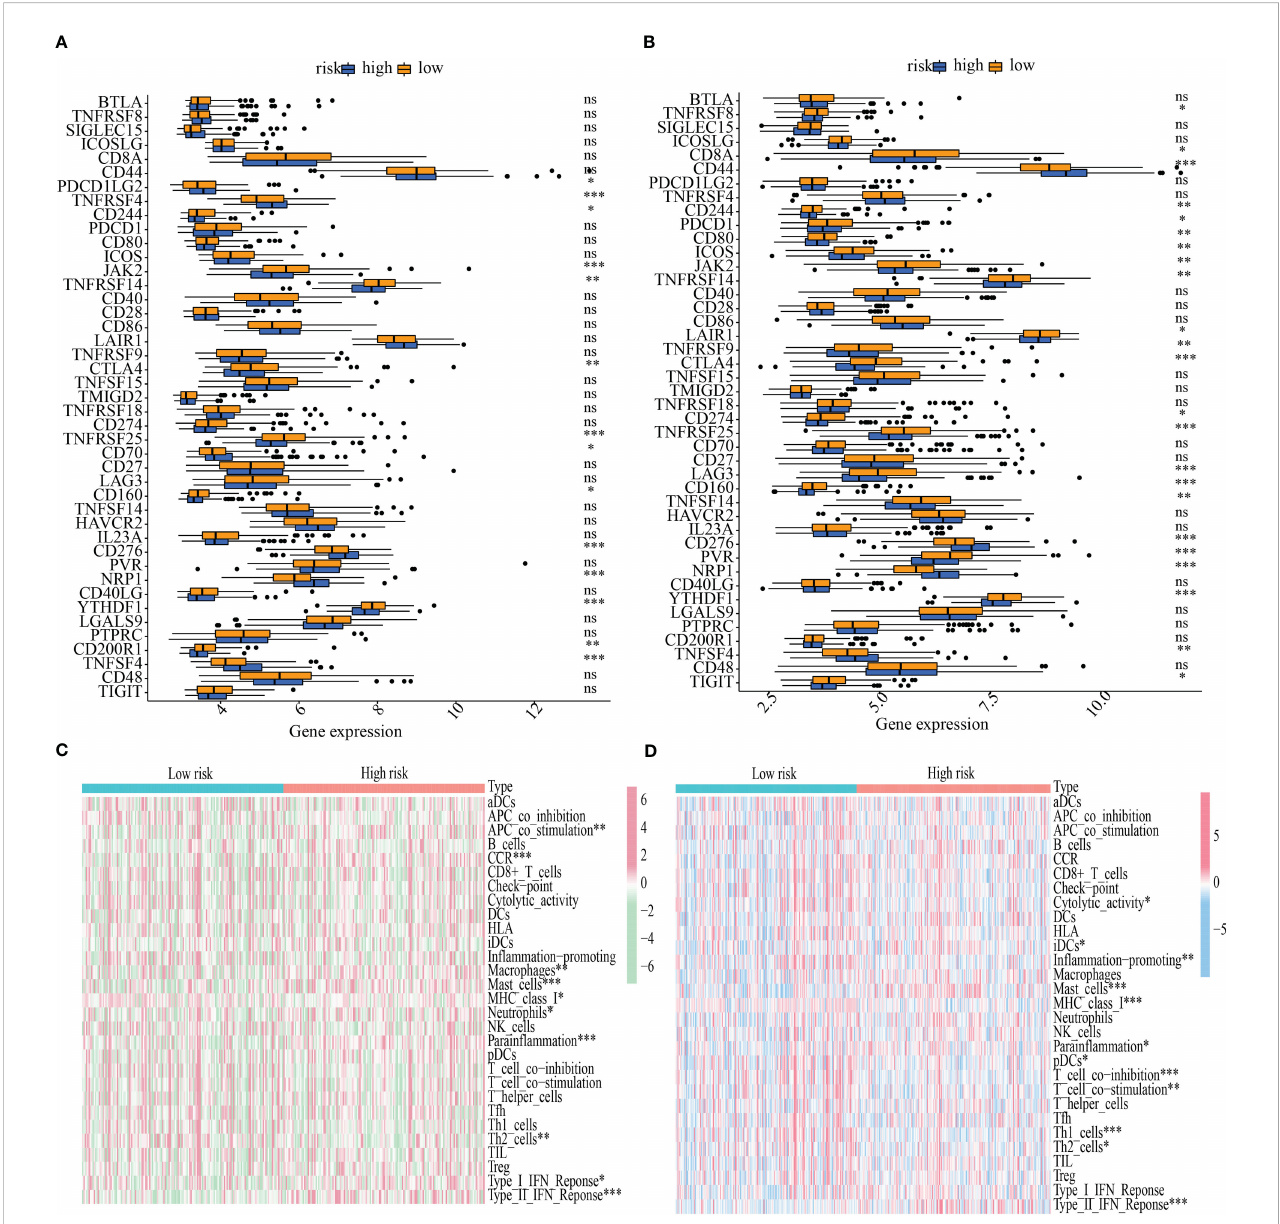
FIGURE 9 Immunological function abundance and immune checkpoint gene expression variations in groups with low and high risk. (A-B) Analysis of the differential expression of ICGs between the training and testing cohorts. (C-D) The state of immune function across the training and the testing cohorts. *P < 0.05; **P < 0.01; ***P < 0.001. ns, no signi fi